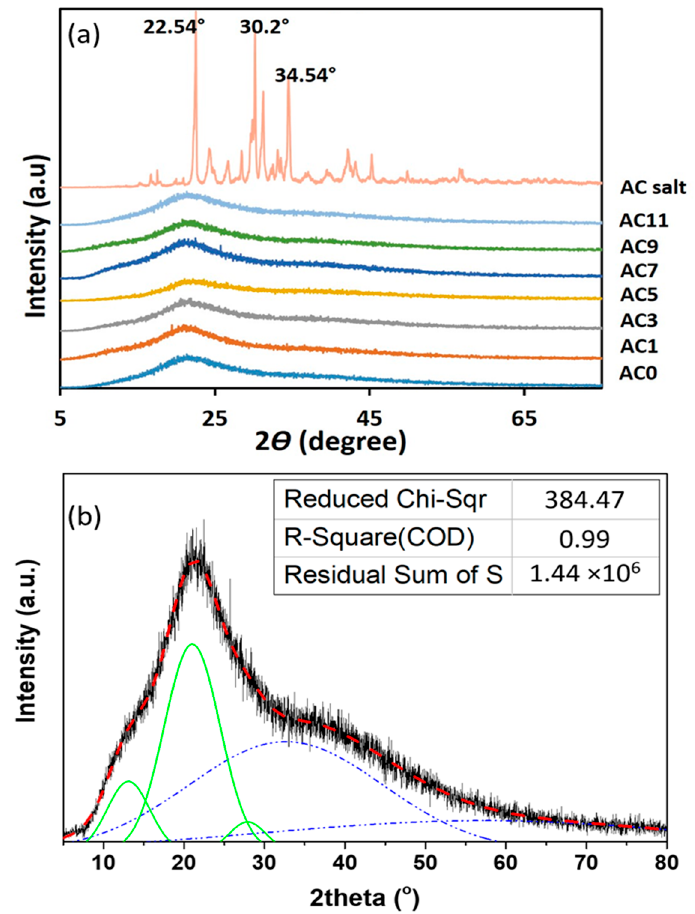
Figure 1. ( a ) The X-ray diffraction (XRD) diffractograms of all CMC-AC biopolymer films. ( b ) The de-convoluted plot of XRD for sample AC7 where green line represents the crystalline phase and blue line represents the amorphous phase.